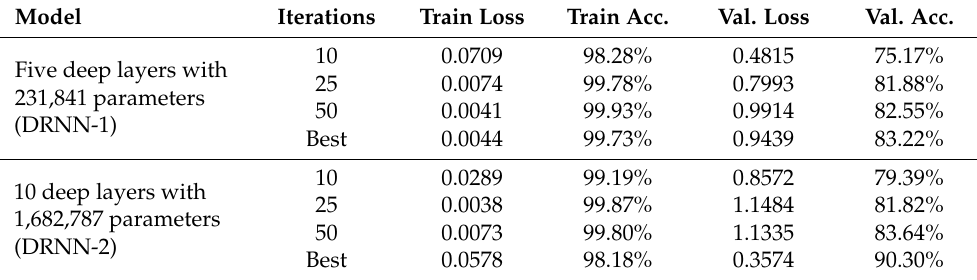
Table 5. Experimental results using the proposed deep recurrent neural network model-based classification method for two classes of Arabic